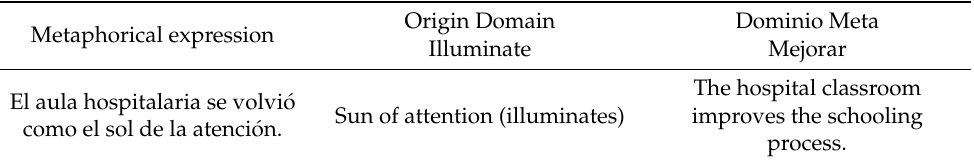
Table 10. To Improve is to Illuminate (Center).